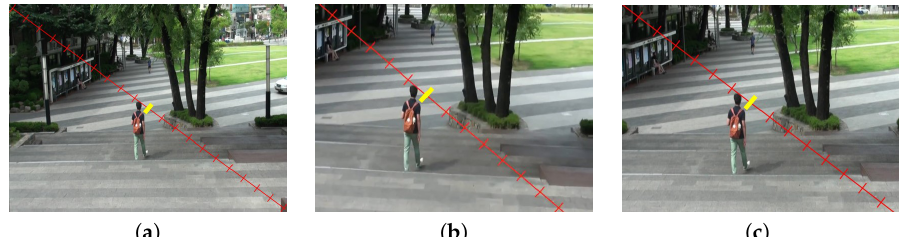
Figure 9. Experimental results of the video stabilization method: ( a ) the input shaky video frame (20/20), ( b ) the stabilized video using auto-directed (13/20) [32], and ( c ) the proposed video stabilization method (16/20).